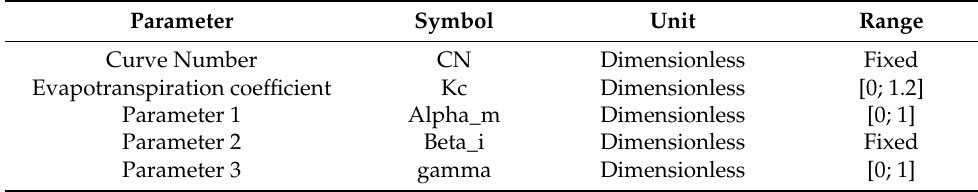
Table 8. Seasonal Water Yield model parameters.